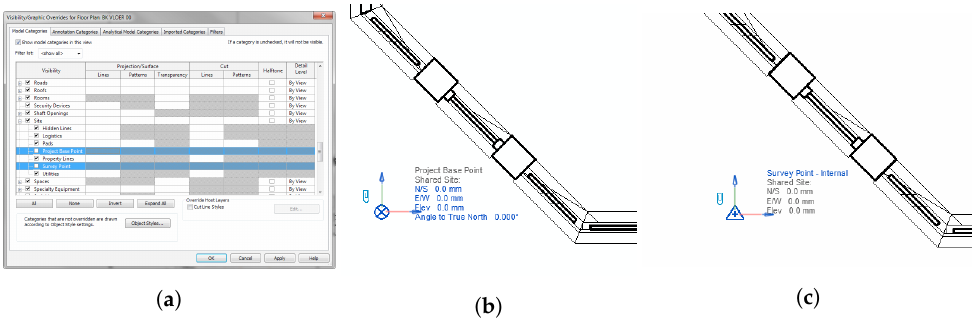
Figure 15. Setting the Project Base Point and Survey Point of the Witte_de_Withstraat model. ( a ) Making the base and survey points visible in Revit; ( b ) Project Base Point; ( c ) Survey Point.